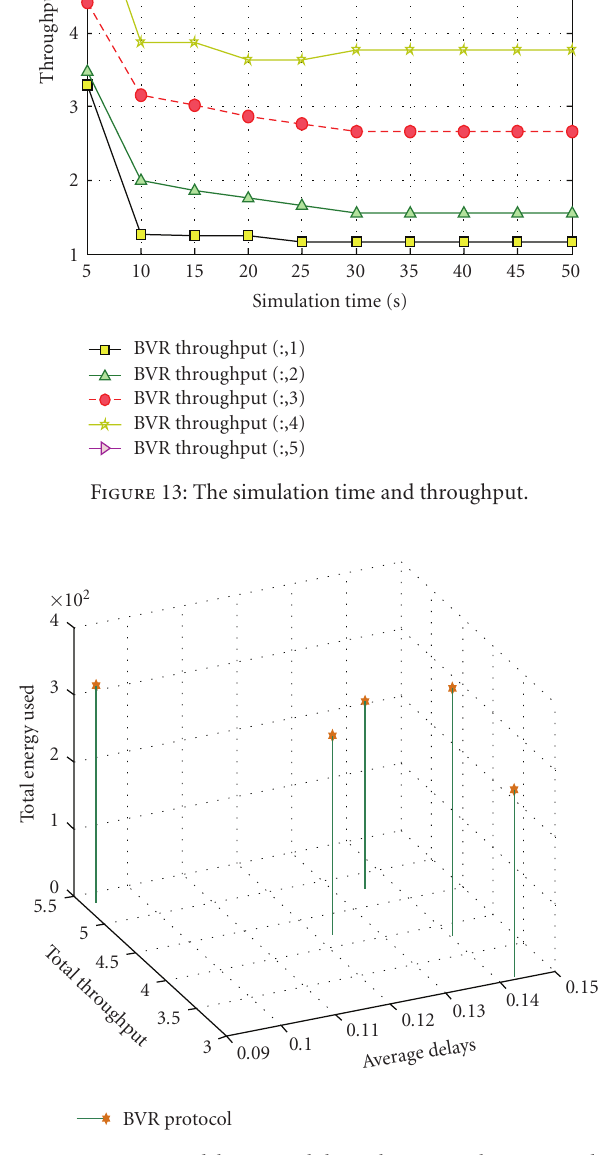
Figure 14: Average delays—total throughput—total energy used. Figure 12: Simulation time and latency. flooding protocol gave the shortest network lifetime. This was expected since flooding is a very energy-consuming